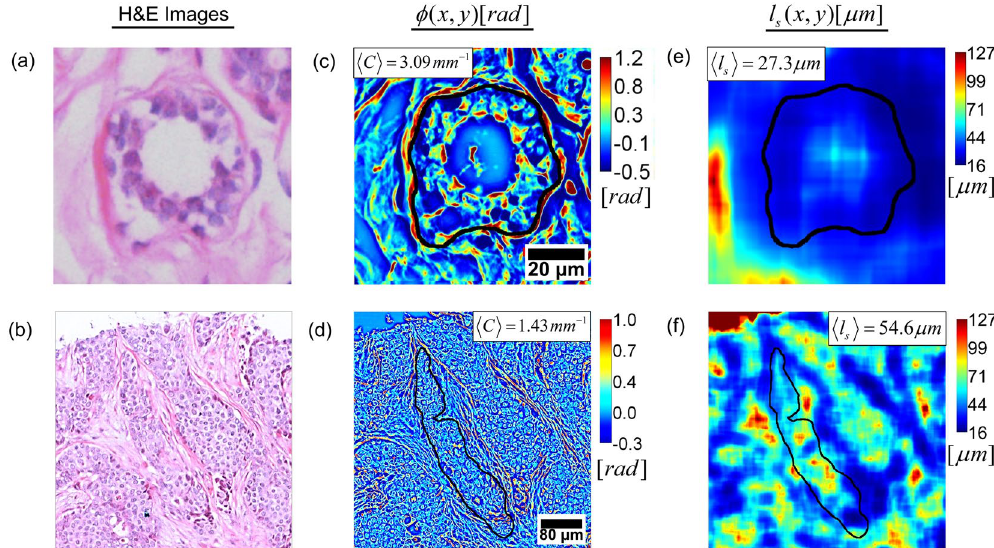
Figure 2. Computing the geometric feature C and scattering feature l over each annotated gland. ( a ) and ( b ) s H&E images of benign and malignant glands, respectively. ( c ) and ( d ) SLIM images of the same benign and malignant glands, respectively, illustrating gland curvature C . The median over gland C is used as the geometric feature for classification. ( e ) and ( f ) l x y ( , ) for benign and malignant glands, respectively. The median s over gland l is used as the scattering feature for s